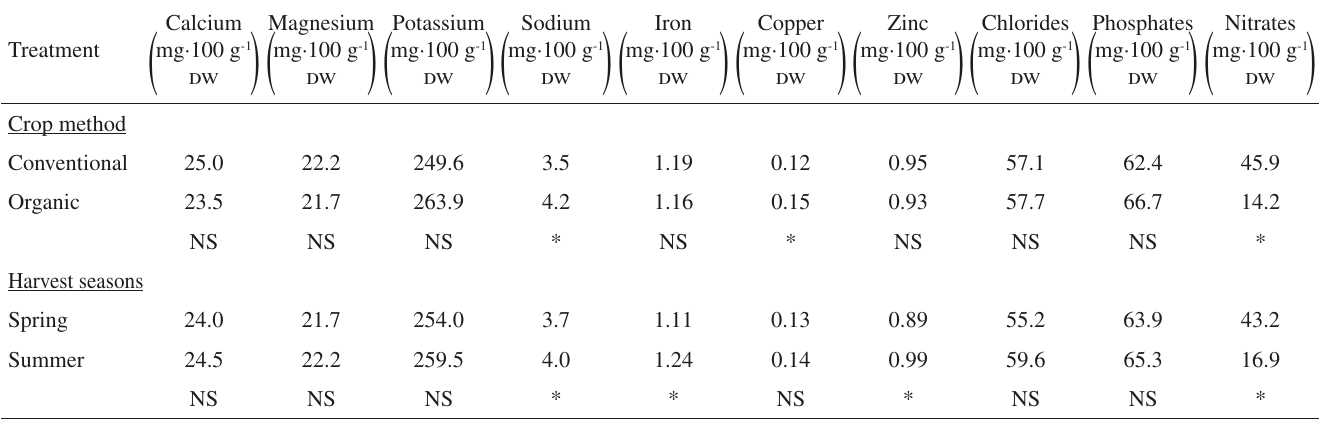
Table 7 - Asparagus spear chemical composition as influenced by crop method and harvest seasons